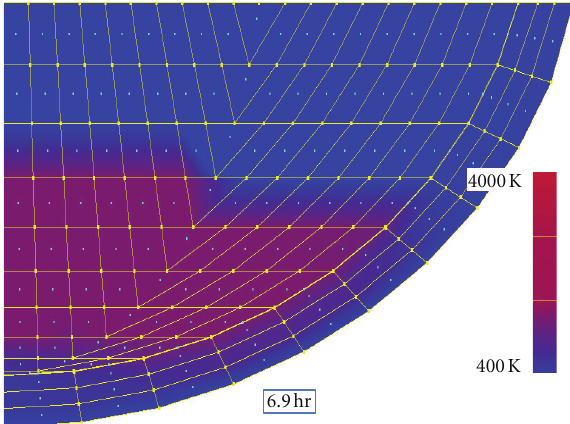
Figure 16: Temperatures in lower plenum at 6.9 hours for a scenario with depressurization and termination of emergency water injection at 4.2 hours after reactor scram (CRD flows maintained).